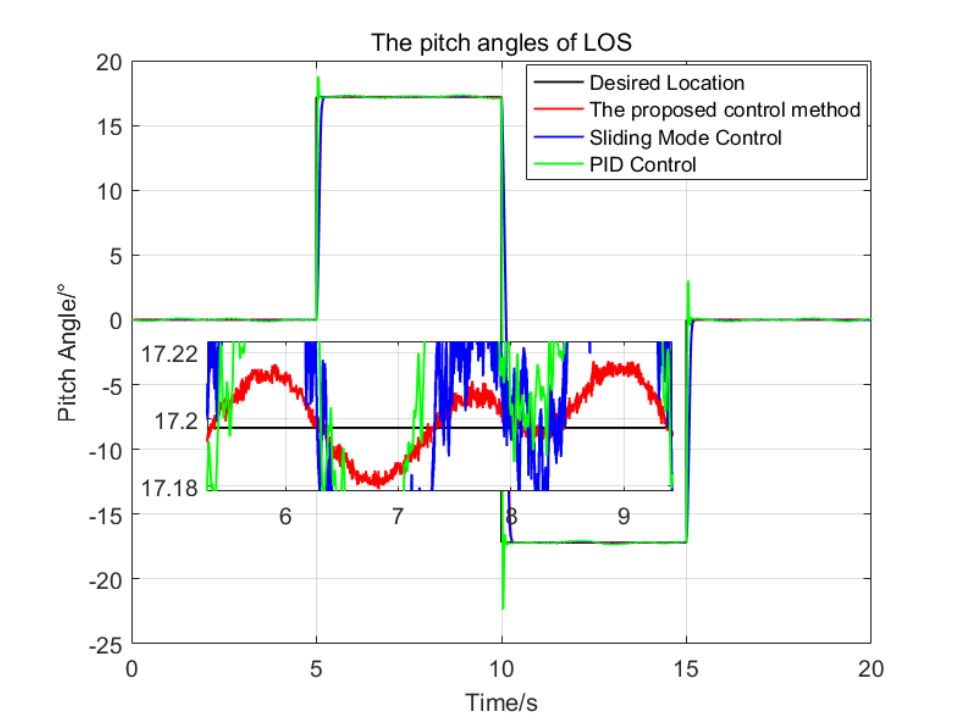
Figure 6. The comparison of the pitch angles of the LOS generated by the three control methods.